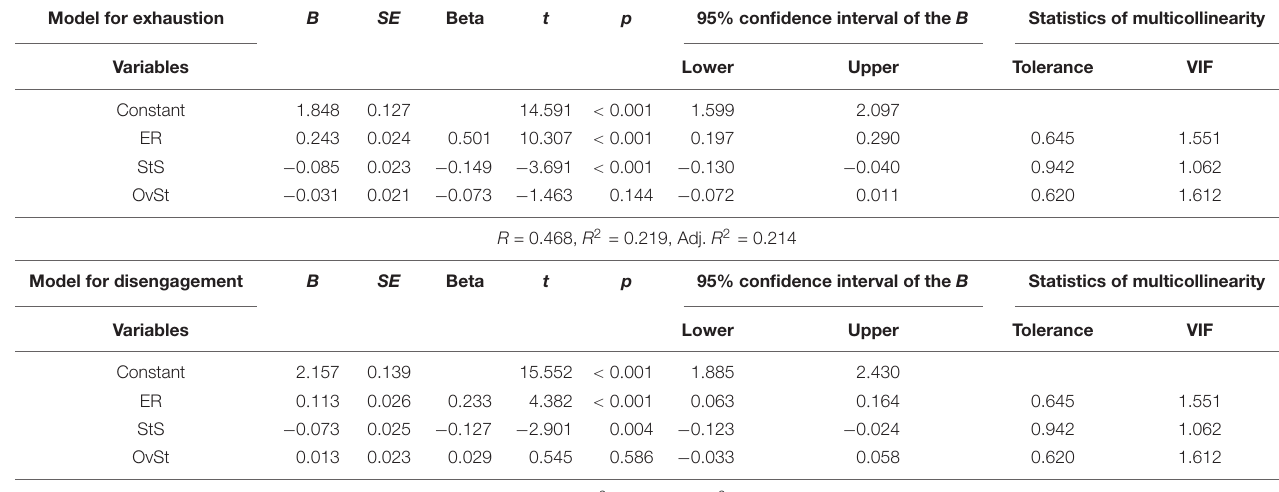
TABLE 6 | Multiple regression analysis for variables predicting exhaustion and disengagement ( N = 516). Model for